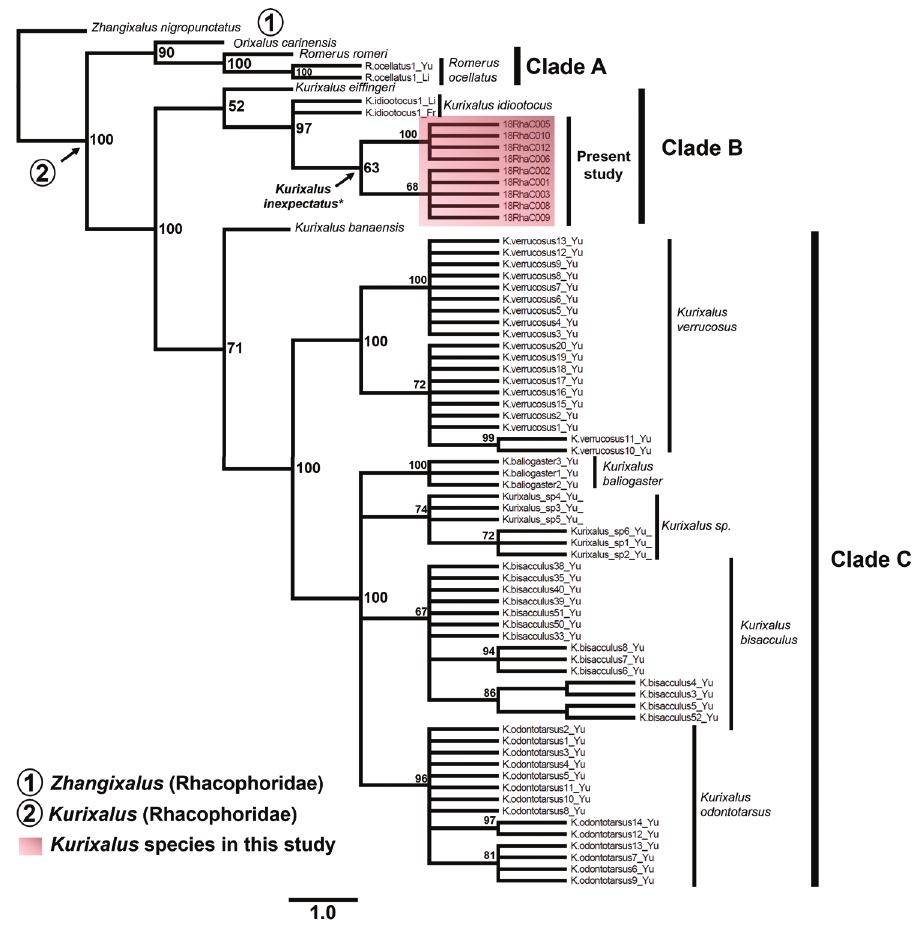
Figure 4. Bayesian Inference (BI) tree inferred from 79 sequences of concatenated 12S rRNA -TYR gene fragments. The three clades (Clades A, B and C ) recovered in the phylogenetic tree are labelled accord- ingly. Clade B included the species K. inexpectatus sp. nov. described in the present study, indicated by the red box. The value of the node represents the Bayesian posterior probability (BPP) for each clade. The clades are marked with a solid bar and labelled in accordance with their specific